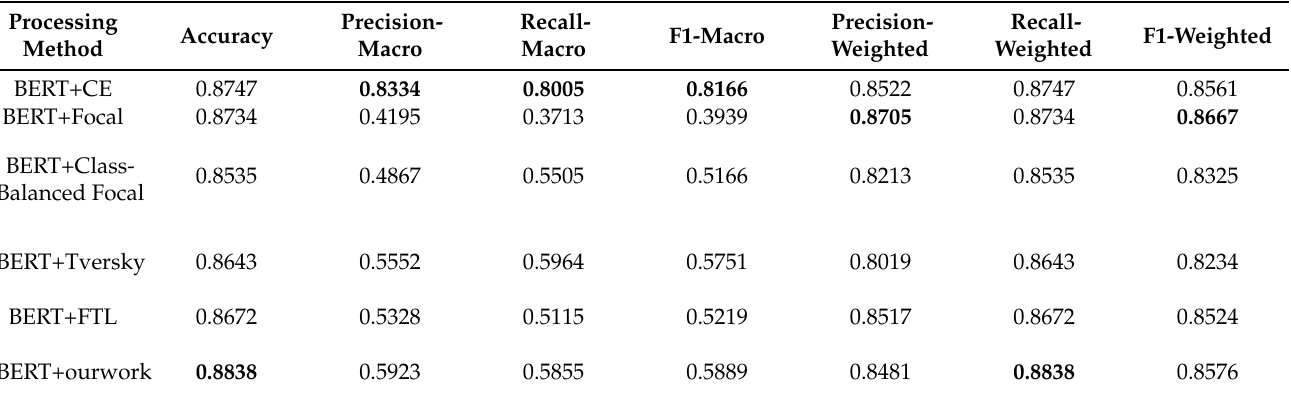
Table 11. Evaluation index values of various loss